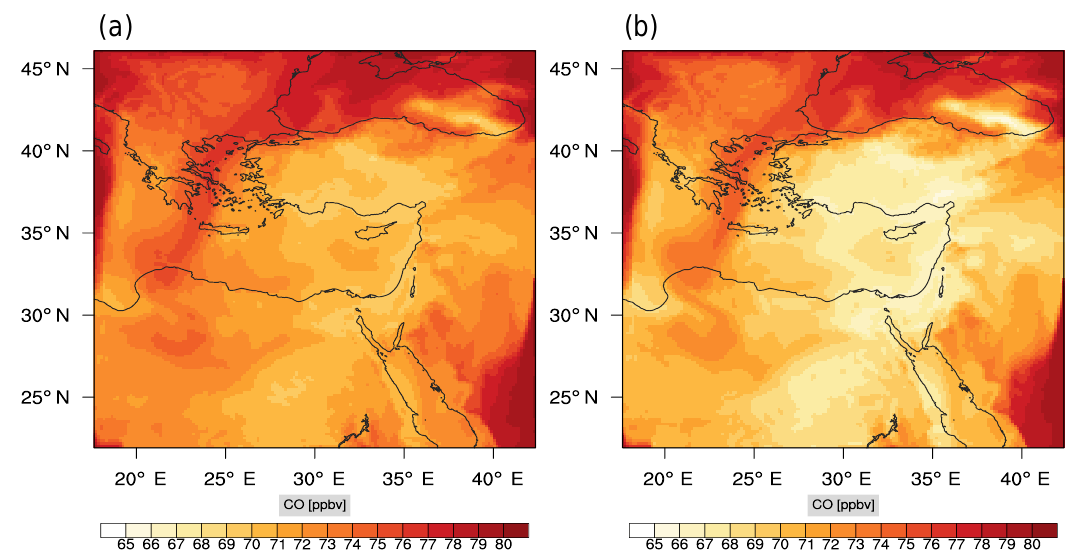
Figure 9. Instantaneous comparison of the carbon monoxide spatial mixing ratio, averaged over the first nine vertical layers, using the full mechanism (a) and the skeletal mechanism (b) .